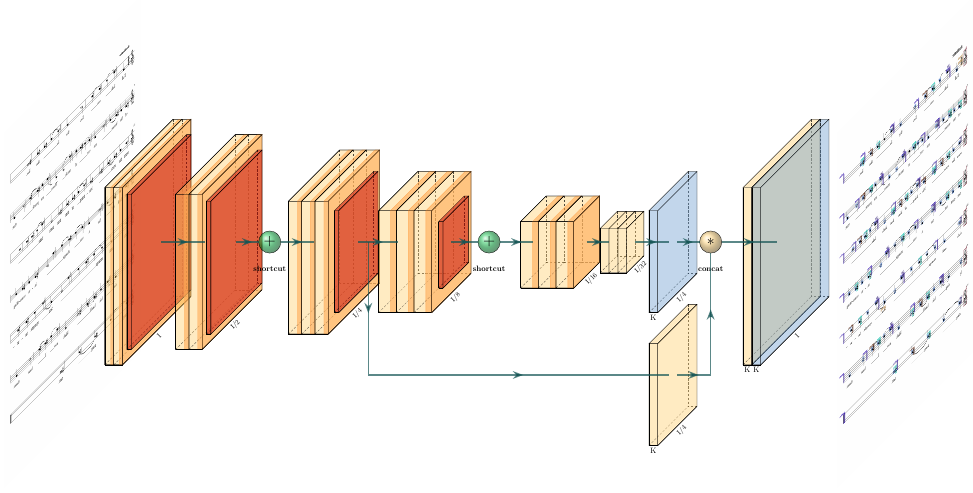
Figure 6. A diagram of the proposed end-to-end object detection model. Darknet53 is applied as the backbone network, the features are extracted using a convolutional neural network, and then upsampling and feature fusion are conducted to get the final feature